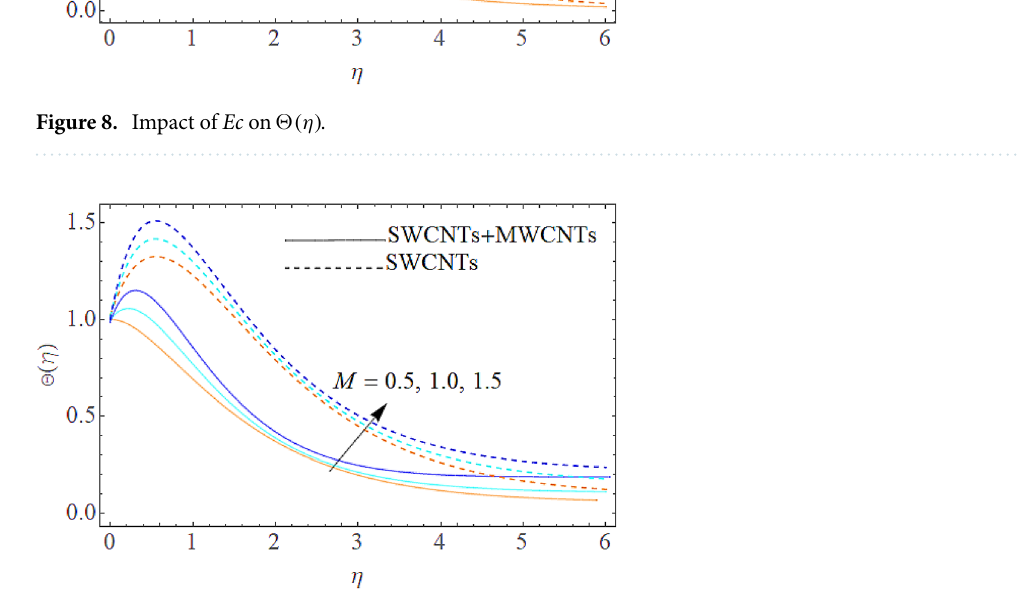
Figure 9. Outcome of M on �(η)